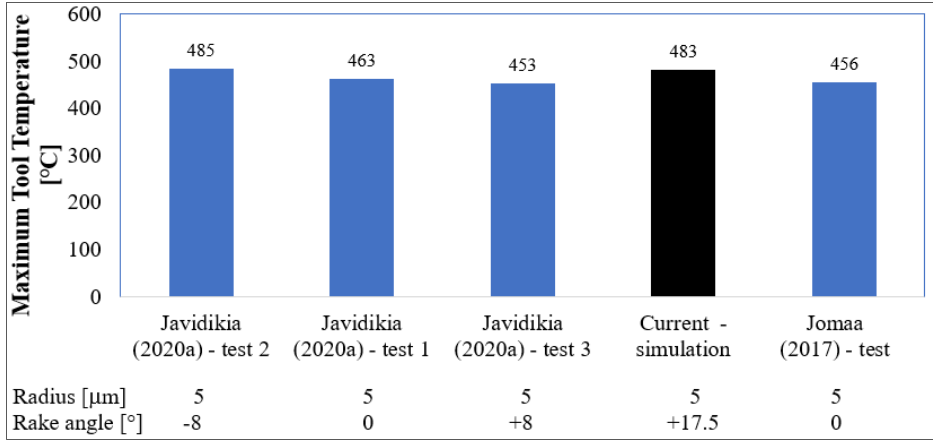
Figure 27. Comparison of simulated temperature and experimental temperature [5,39].